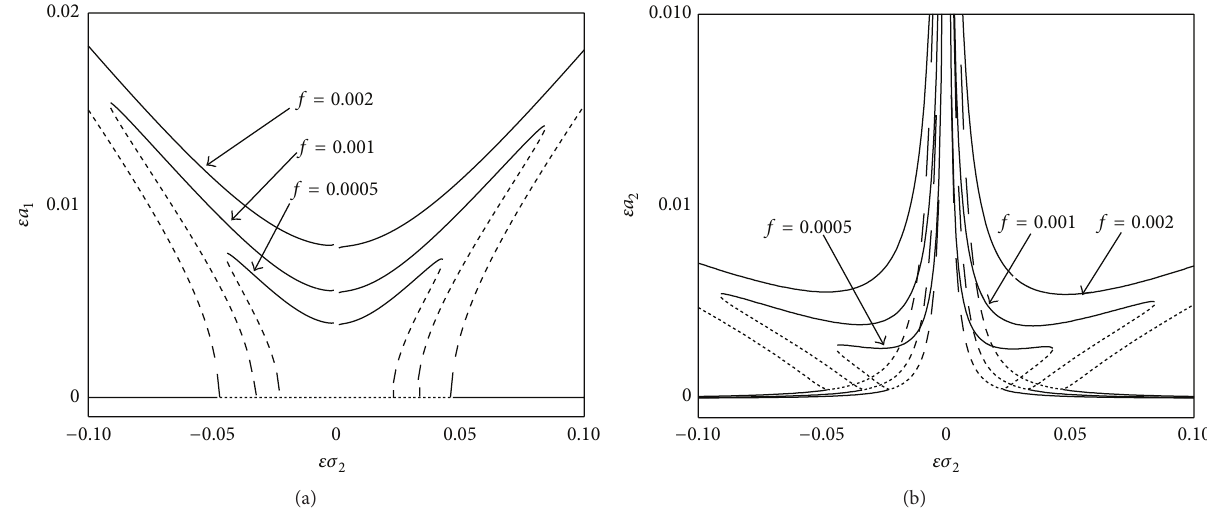
Figure 3: Amplitude-frequency curves of the first subharmonic resonance for different external excitation amplitudes: (a) the first mode and (b) the second